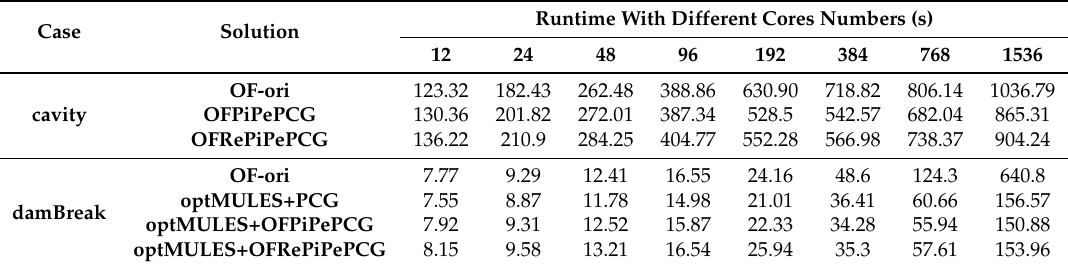
Table 9. Results of weak scaling